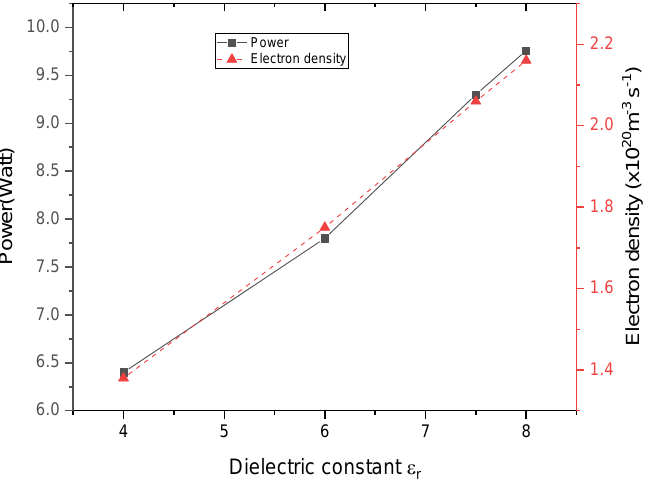
Figure 11. Evolution of electron number density N e and consumed power P with different ε r .